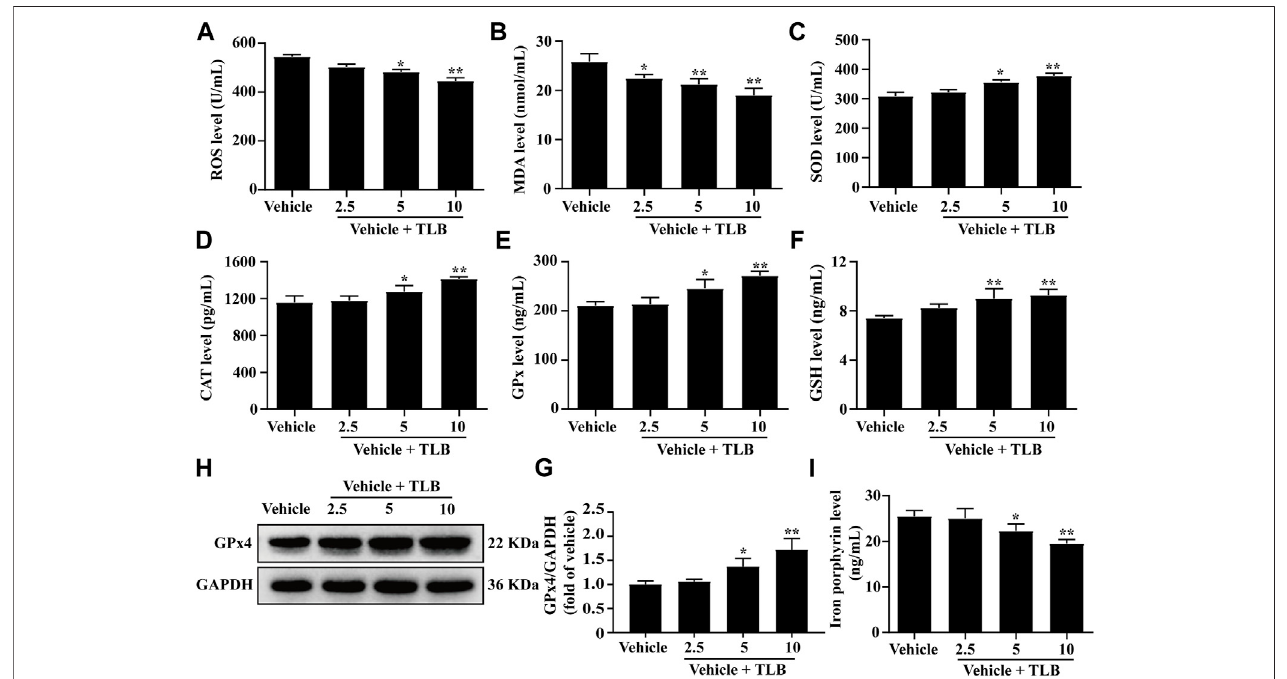
FIGURE 2 | Effect of TLB on EEIF-induced oxidative stress and ferroptosis in mice. (A) ROS level ( n = 6), (B) MDA level ( n = 6), (C) CAT activity ( n = 6), (D) SOD activity ( n = 6), (E) GPxactivity ( n = 6), (F) GSH level ( n = 6), (H) representative Western blots ofGPx4, (G) quantitation of GPx4 ( n = 5), and (I) iron porphyrin level ( n = 6). The data were presented as the mean ± SEM. * p < 0.05 and ** p < 0.01 vs vehicle group.